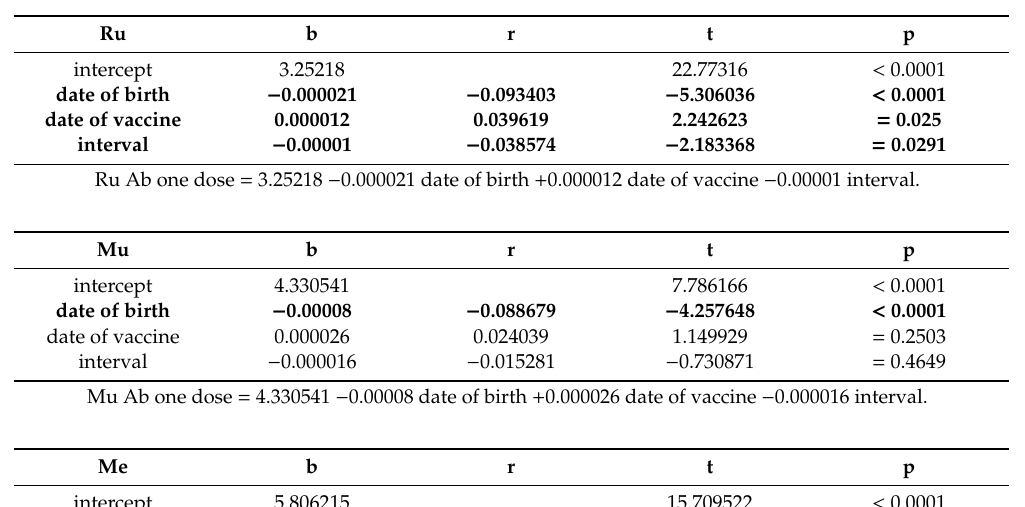
Table 2. Multiple linear regression among antibodies (Ab) of Ru, Mu and Me after one dose and the independent variables date of birth, date of vaccine, and interval between vaccination and antibody measurement. Significant results are shown in bold .